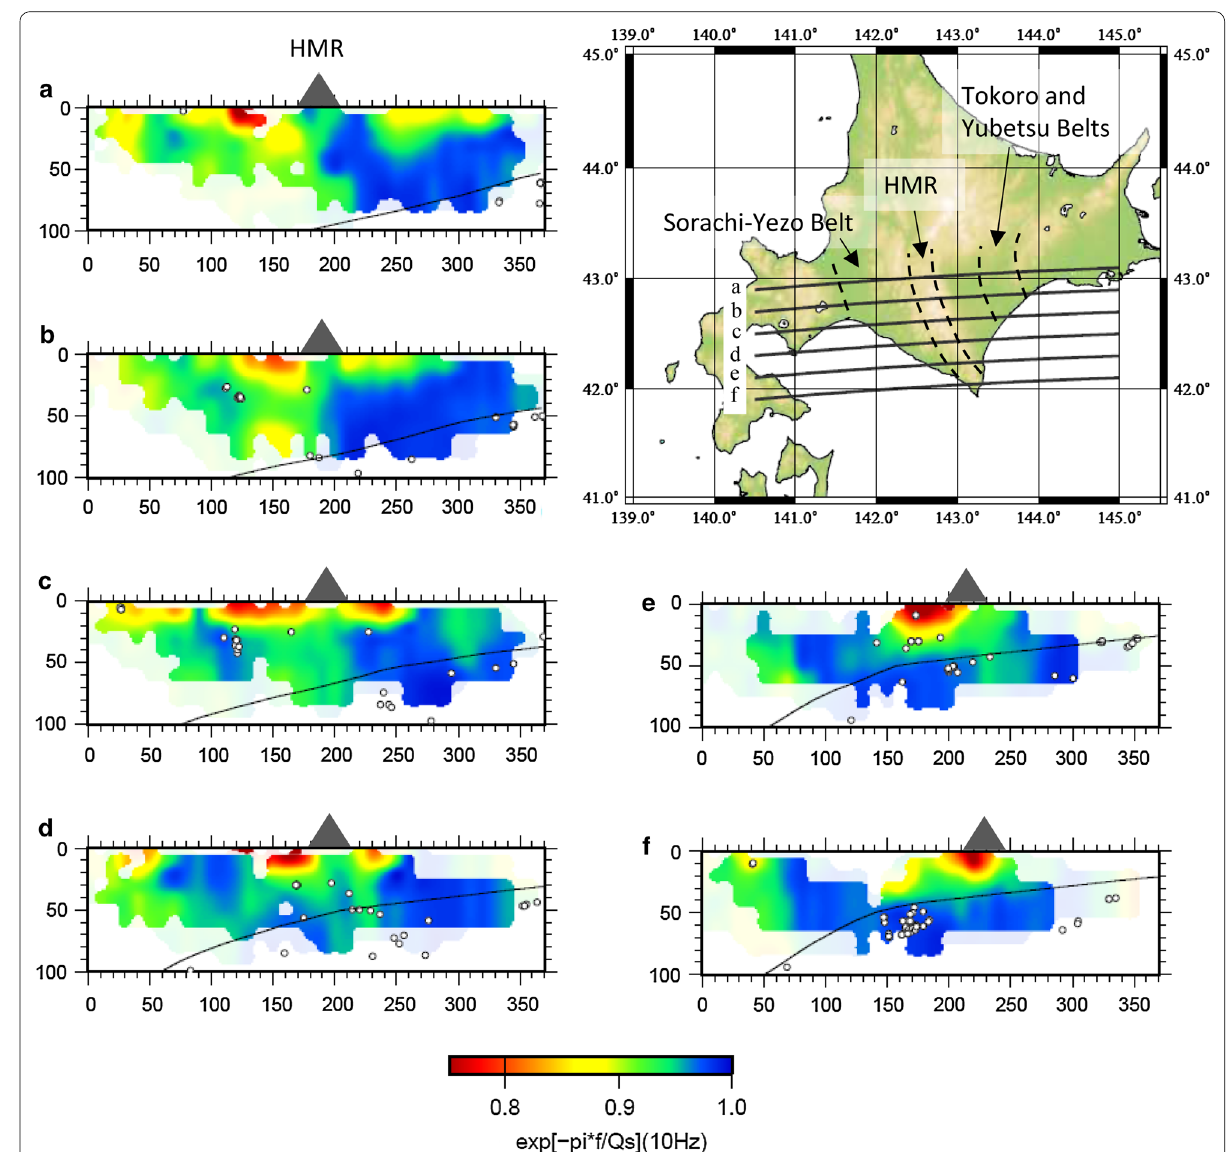
Fig. 4 Vertical cross-sections of Qs structures at 10 Hz. The black curves represent the upper boundary of the Pacific slab (Nakajima et al. 2009). Dashed lines in the inset map denote separate characteristics of surface topography, such as geological boundary or the Hidaka mountain ranges